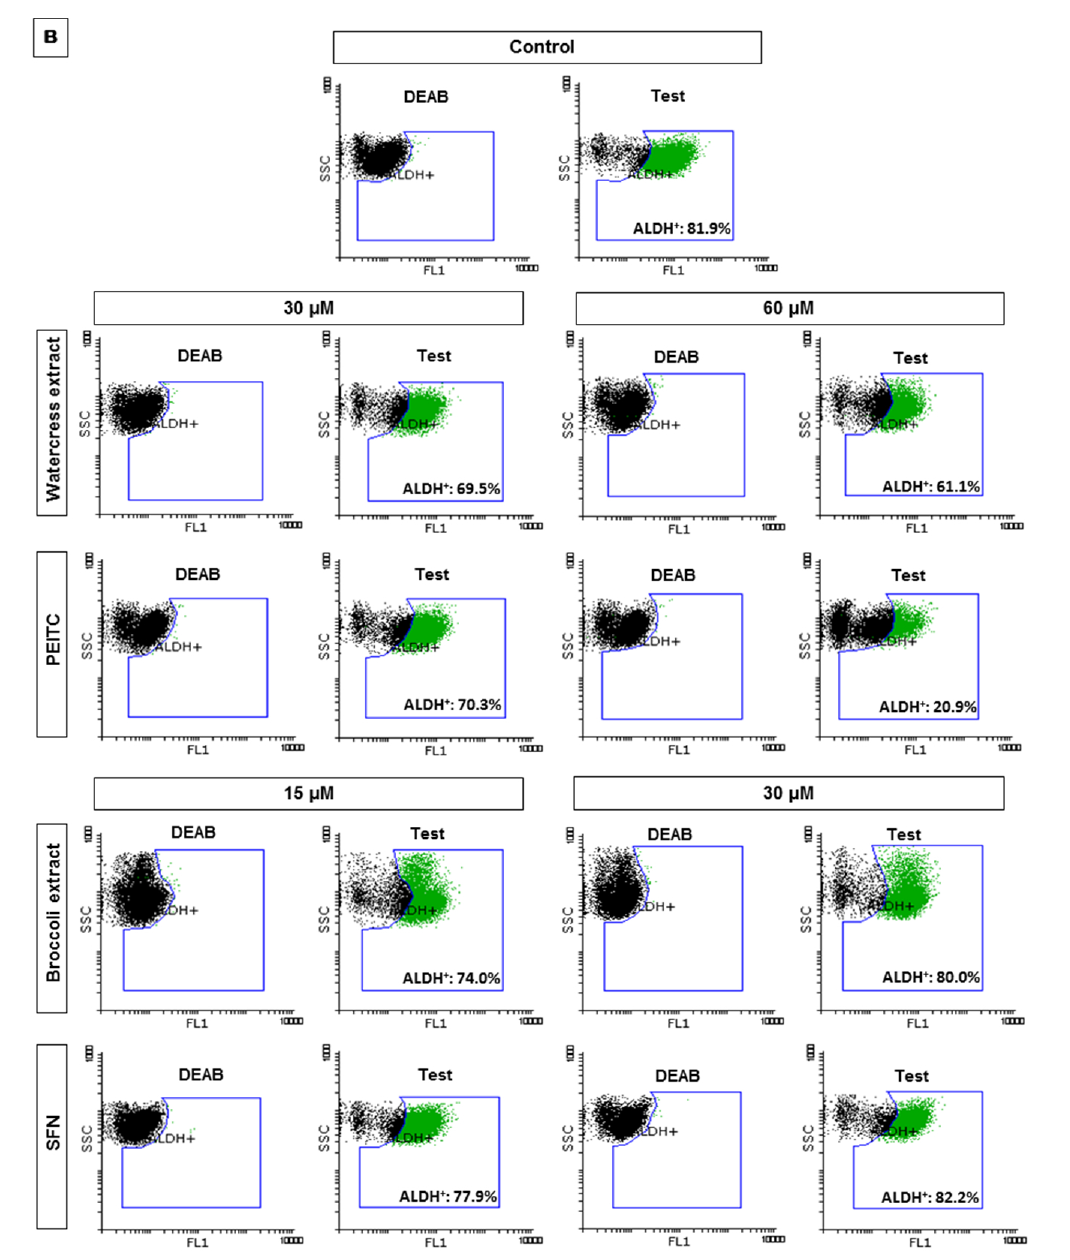
Figure 5. ALDH1 activity in HT29 spheroids after exposition to watercress and broccoli extracts and respective main ITCs, PEITC and SFN, for 24 h assessed by the ALDEFLUOR™ assay. ALDH1 activity was assessed after treatment with submaximal dosages of all phytochemicals, more precisely with 1 and 1 of extracts’ EC 50 values obtained in 3D antiproliferative assay. ( A ) Effect of natural 2 4 extracts and ITCs in ALDH1 activity normalized relatively to control without treatment or solvent (100% ALDH1 activity). Results are means of at least two independent experiments performed in duplicate ± SD; a p < 0.05 was considered as statistically significant. **** p < 0.0001 is relative to control; ΨΨ p < 0.01 is relative to watercress extract and ωωωω p < 0.0001 is relative to the same compound; ( B ) Representative dot-plots of ALDH1 subpopulations in HT29 spheroids from flow cytometry analysis using ALDEFLUOR™ assay. Negative control was treated with DEAB (ALDH1 inhibitor). The content of ALDH + cells for each representative sample is indicated as % relatively to total cell